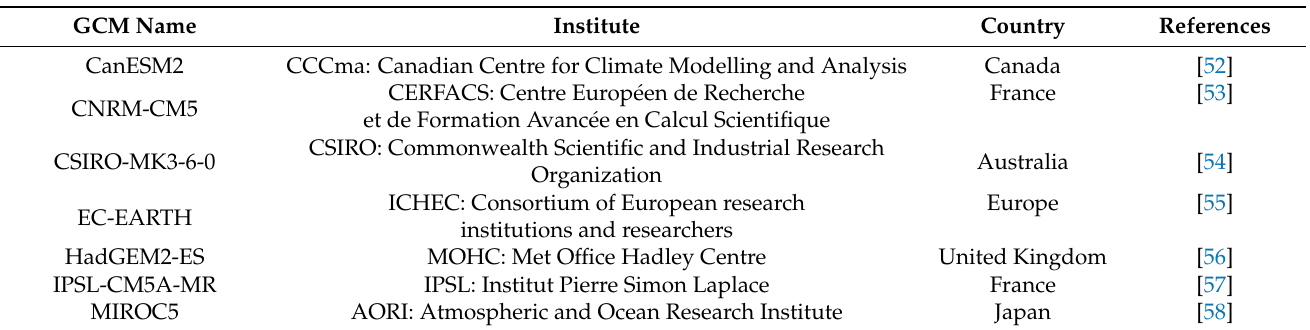
Table 2. Description of the global climate models (GCMs)